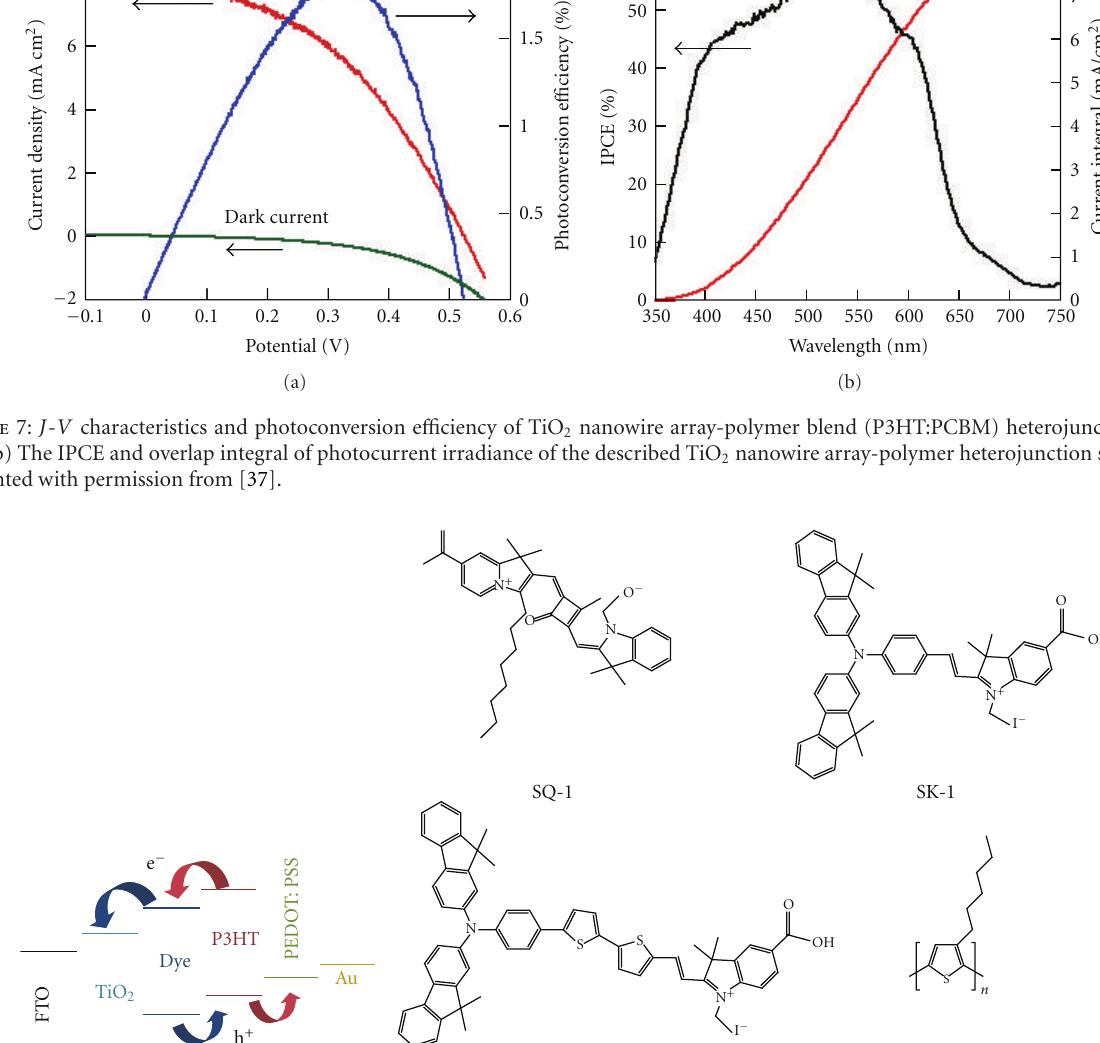
of N-719 dye by immersion in a 0.5 mM ethanol solution